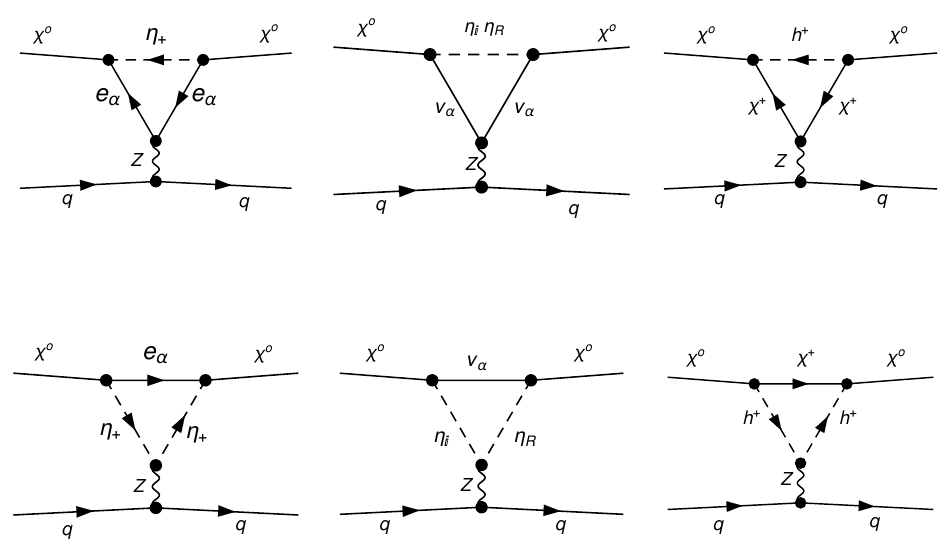
Figure 10 . Diagrams contributing to SD cross-section at one-loop level. They were generated using FeynArts